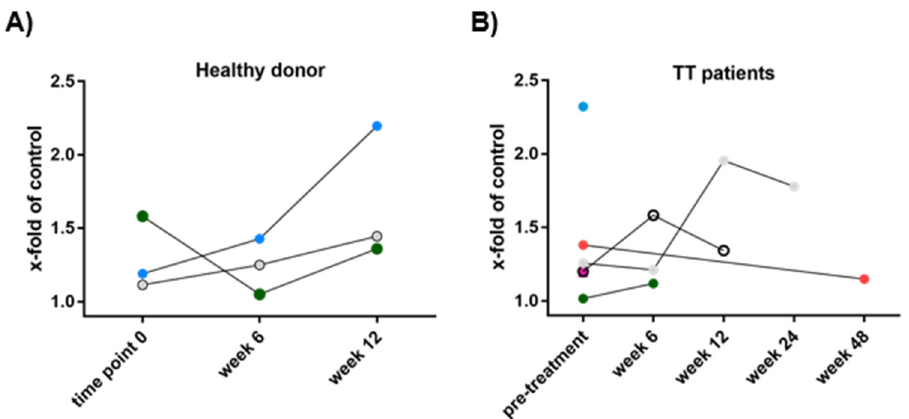
Figure 5. Sequential assessment of cytotoxicity by peripheral blood eosinophils towards melanoma cells. Eosinophils from melanoma patients were isolated prior to treatment and during therapy at weeks 6, 12, 24 and 48. Co-culture of MaMel63a cells and eosinophils serially obtained from ( A ) healthy donors (HD) or ( B ) stage IV melanoma patients subsequently receiving targeted therapy (TT) in a 1:7.5 ratio, non-adherent for 24 h. In order to display eosinophil-induced MaMel63a cell death, viability of MaMel63a cells relative to controls was plotted inversely. A high number refers to a high cytotoxic eosinophilic activity. Each symbol represents a healthy donor or patient, respectively. Eosinophil-mediated cytotoxicity towards MaMel63a cells is donor-dependent. n = three healthy donors, n = six patient samples obtained prior to melanoma treatment. 3.7. Tumoricidal Effect of Eosinophils Depends on Culture Conditions and it is an Active Process Requiring Cell–Cell Contact To unravel the underlying mechanism of melanoma cell–eosinophil interactions, we initially performed co-cultures under non-adherent culture conditions, forcing an interaction of melanoma cell lines with their surrounding co-cultured cells. By allowing melanoma cells to adhere to a given surface, the reduction in MaMel63a cell viability by eosinophils after 24 h was not measureable anymore (Figure 6A). Whether cytotoxicity is mediated by receptor engagement or soluble factors was determined by transwell experiments, where cultured eosinophils and melanoma cells were separated by a